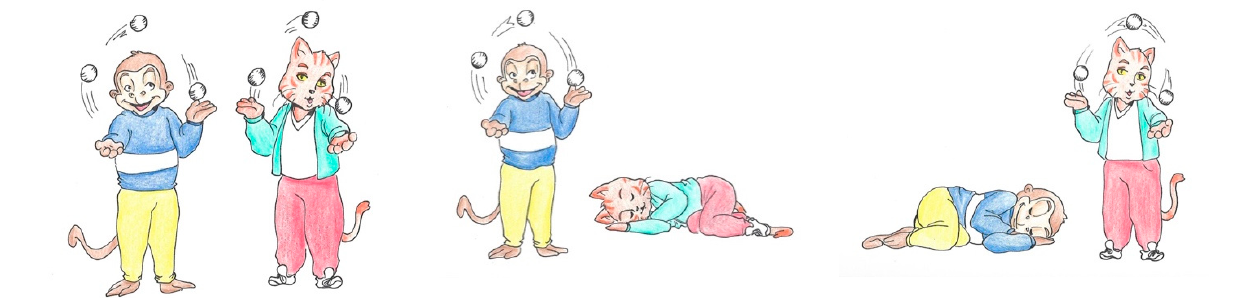
Figure A37. Filler stimulus 12. El gato manda al oso a saltar, y lo hace.